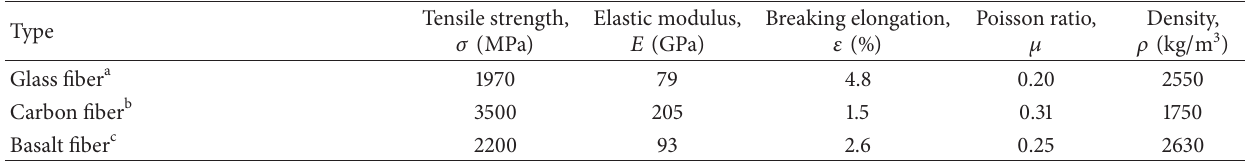
Table 1: Properties of fibers.